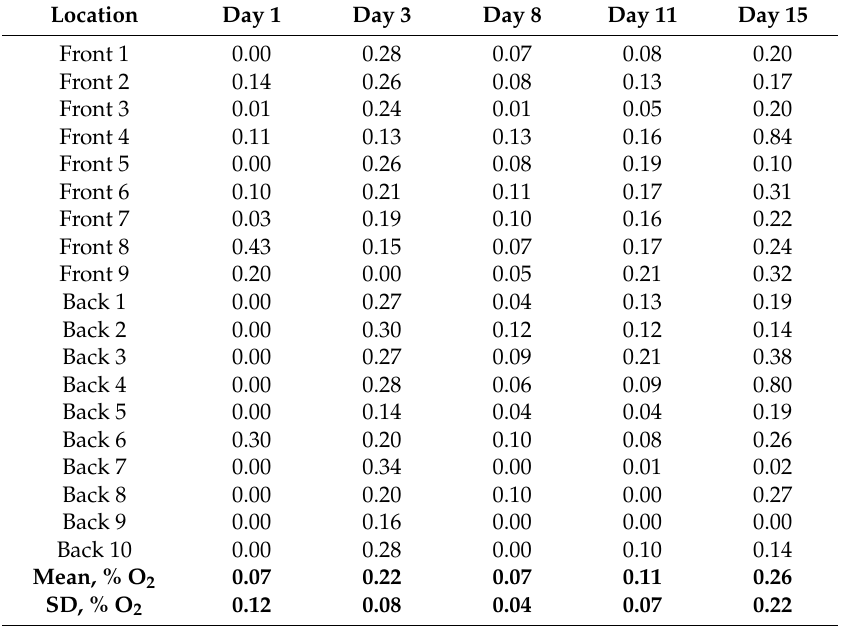
Table 3. Residual O 2 level readings (%) for each sensor in Bin 3 over a 15-day storage